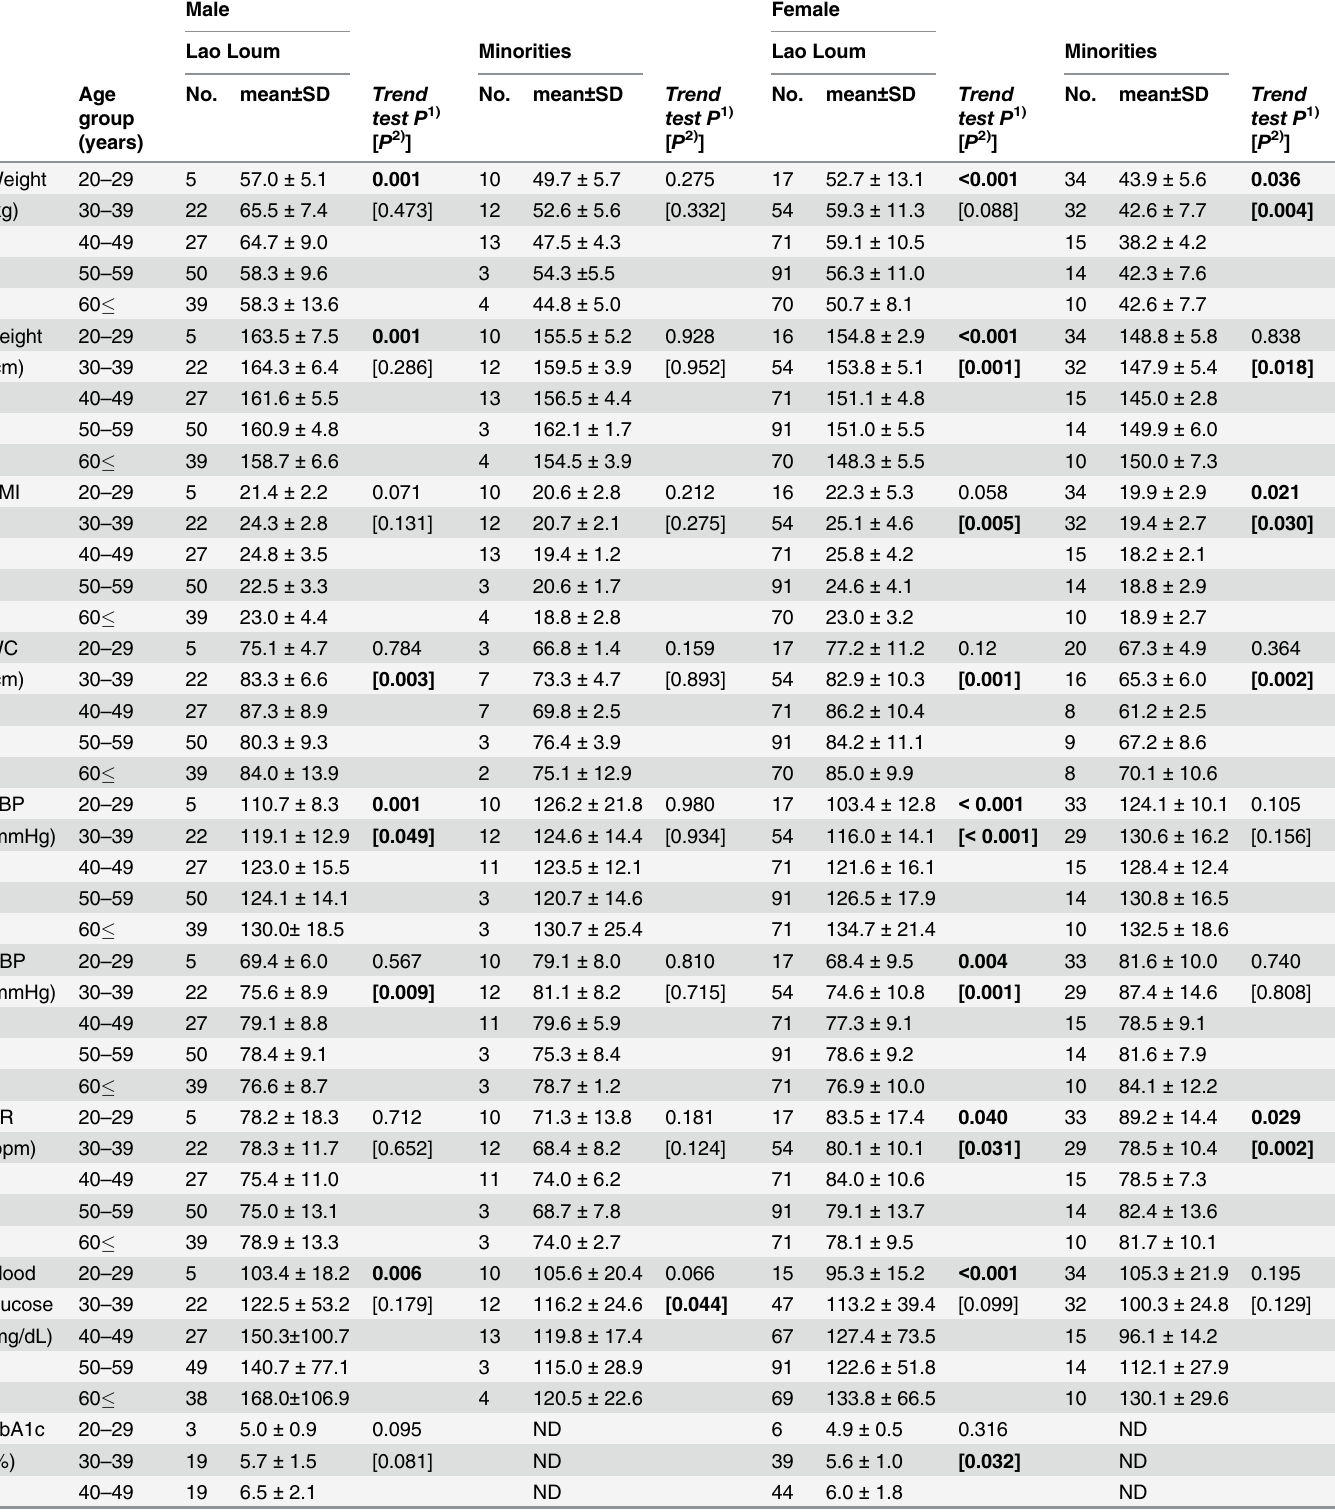
Table 3. Anthropometric and clinical characteristics of age categories in Lao Loum and